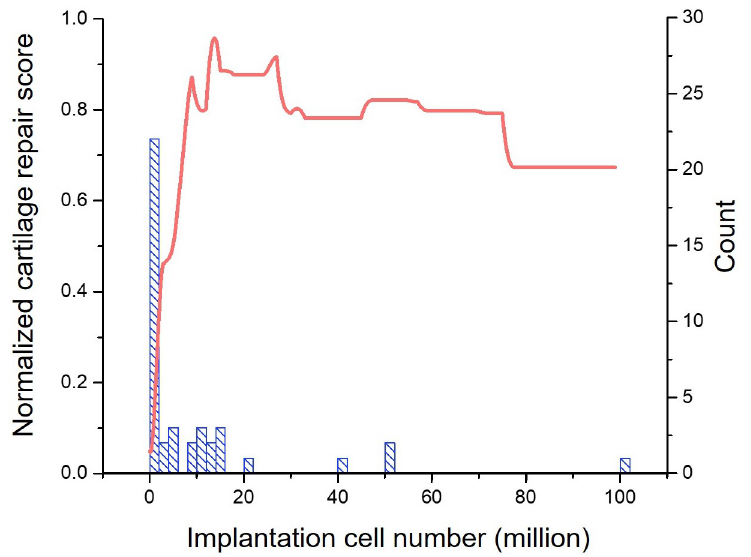
Fig 8. Impact of implantation cell number on the cartilage repair. The left y-axis shows the predicted patient’s cartilage repair scores normalized to the range of score that patients have been evaluated in clinical trials. The right y- axis shows the number of studies (blue histogram) that use a certain cell number in our